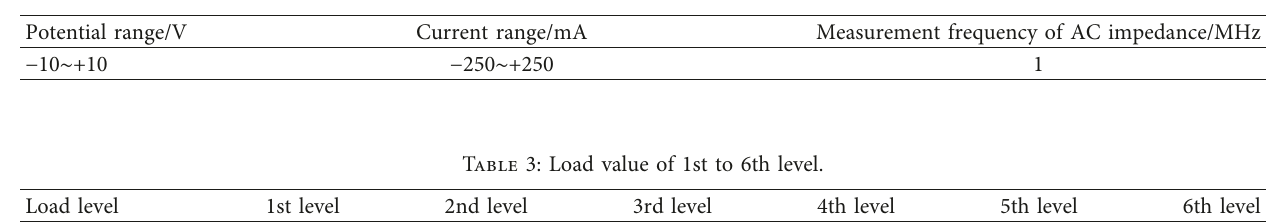
Table 2: Parameters of electrochemical workstation.